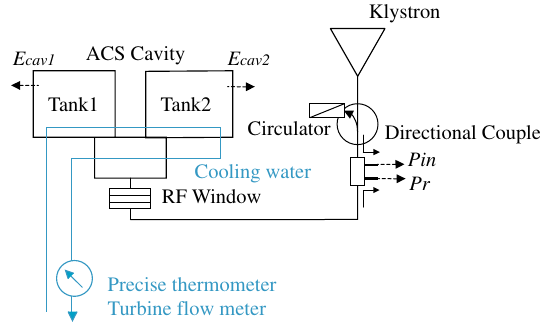
FIG. 10. Schematic view of the monitoring system for the cavity performance.